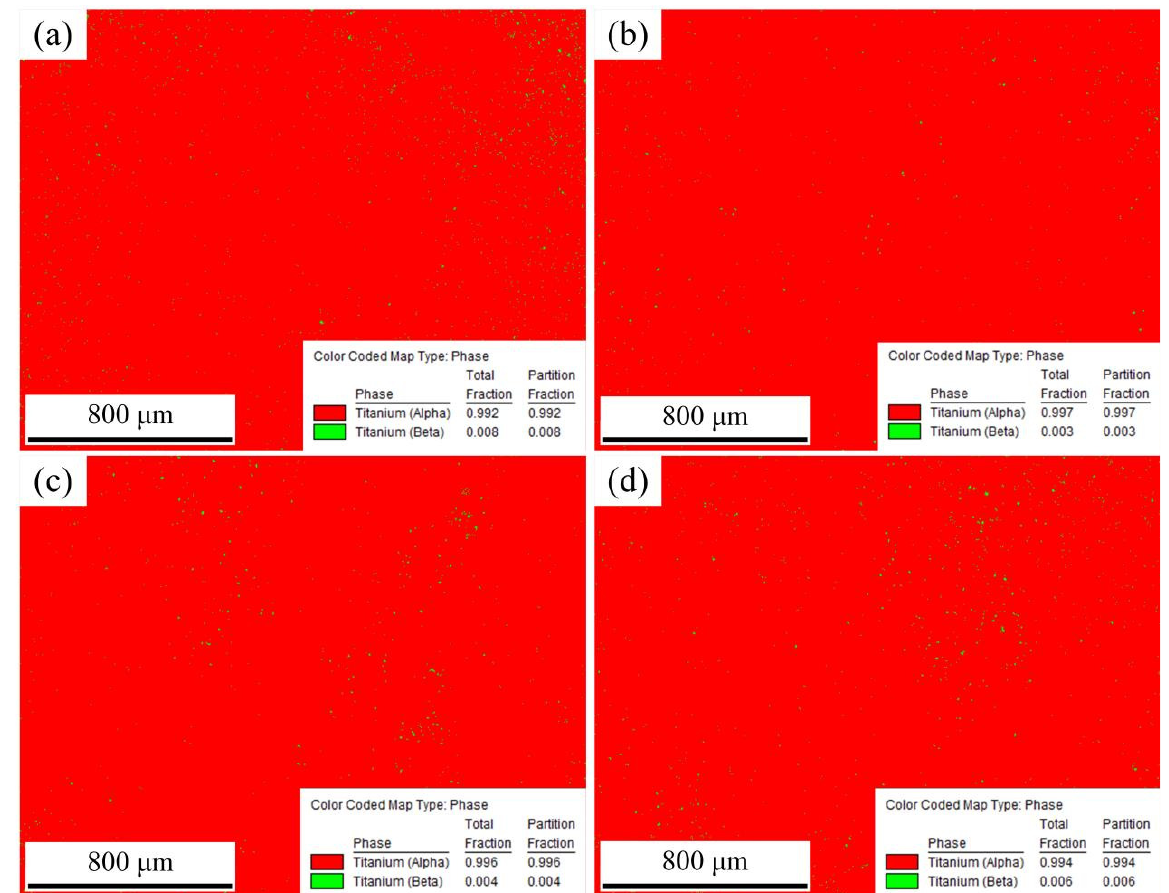
Figure 8. Phase distribution of the cross-section of the deposition layer obtained by using wire feeding speed of 4 m/min. (Note: ( a ) MIG, ( b ) M-MIG with magnetic excitation current of 1A, ( c ) M-MIG with magnetic excitation current of 2A, ( d ) M-MIG with magnetic excitation current of 3A)